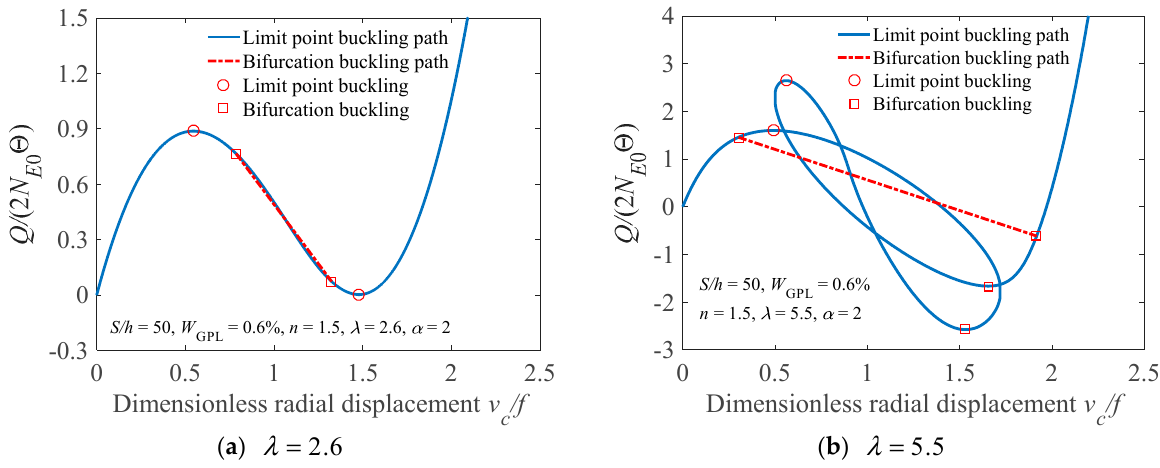
Figure 8. Nonlinear load-displacement curve of an elastically restrained FG-GPLRC arch.